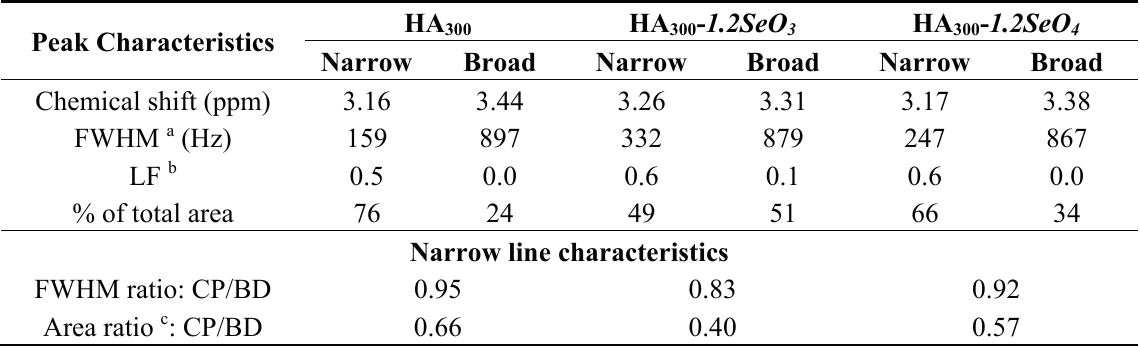
( A ) ( B ) Figure 2. 31 P BD ( A ) and CP ( B ) MAS NMR spectra of the analysed samples. Table 2. Curve fitting results for the 31 P CP NMR spectra (MAS at 7.0 kHz, the CP contact time of 2 ms). The peaks have been assigned according to Pajchel et al.